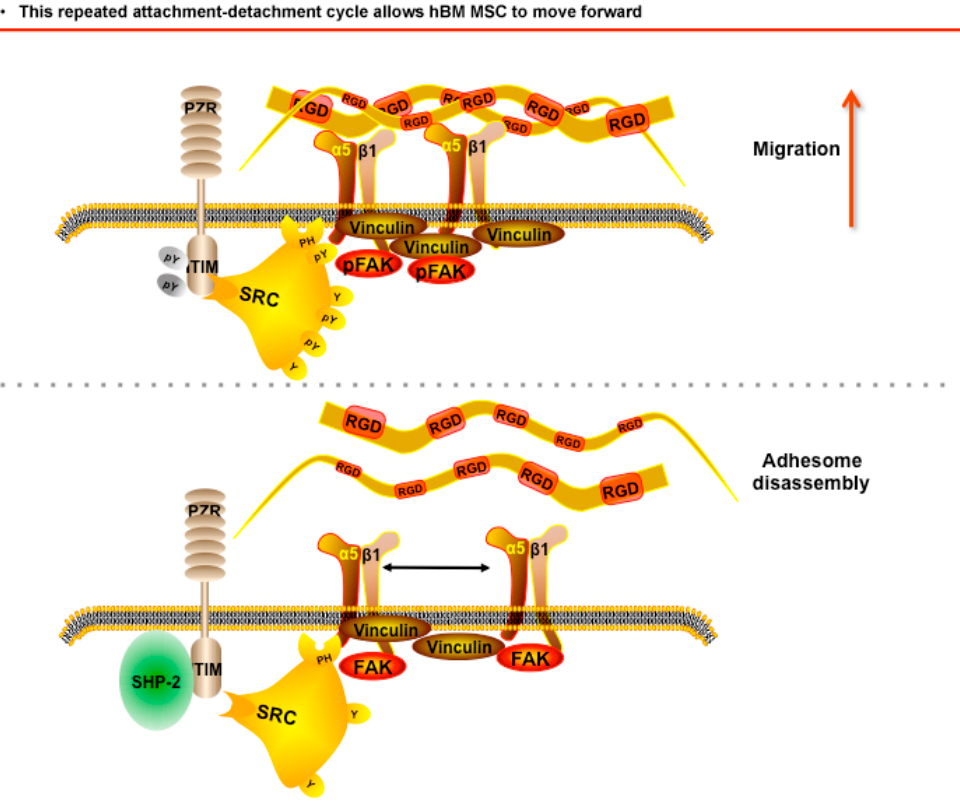
Figure 6. Key results and proposed mechanism of action of PZR in promoting integrin VLA-5( α 5 β 1)-mediated hBM MSC migration on fibronectin. Many proteins are present in